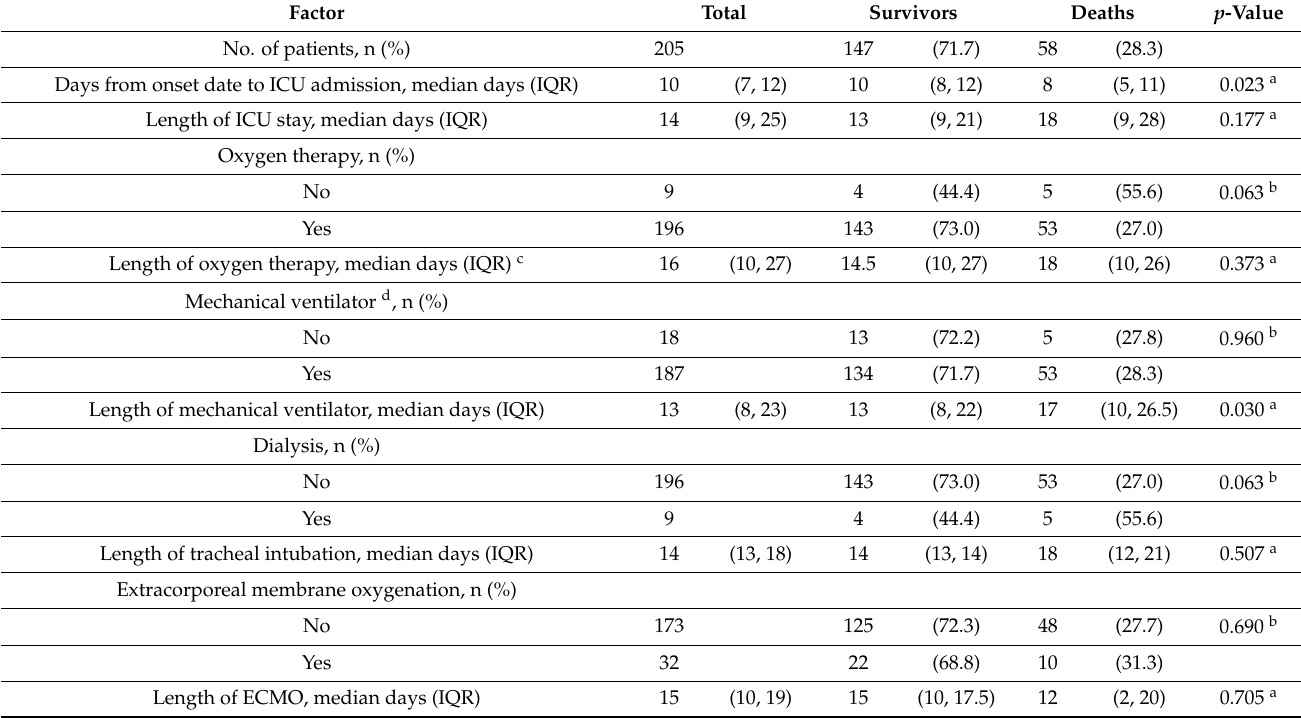
Table 2. Clinical characteristics of patients admitted to the intensive care unit in Osaka,